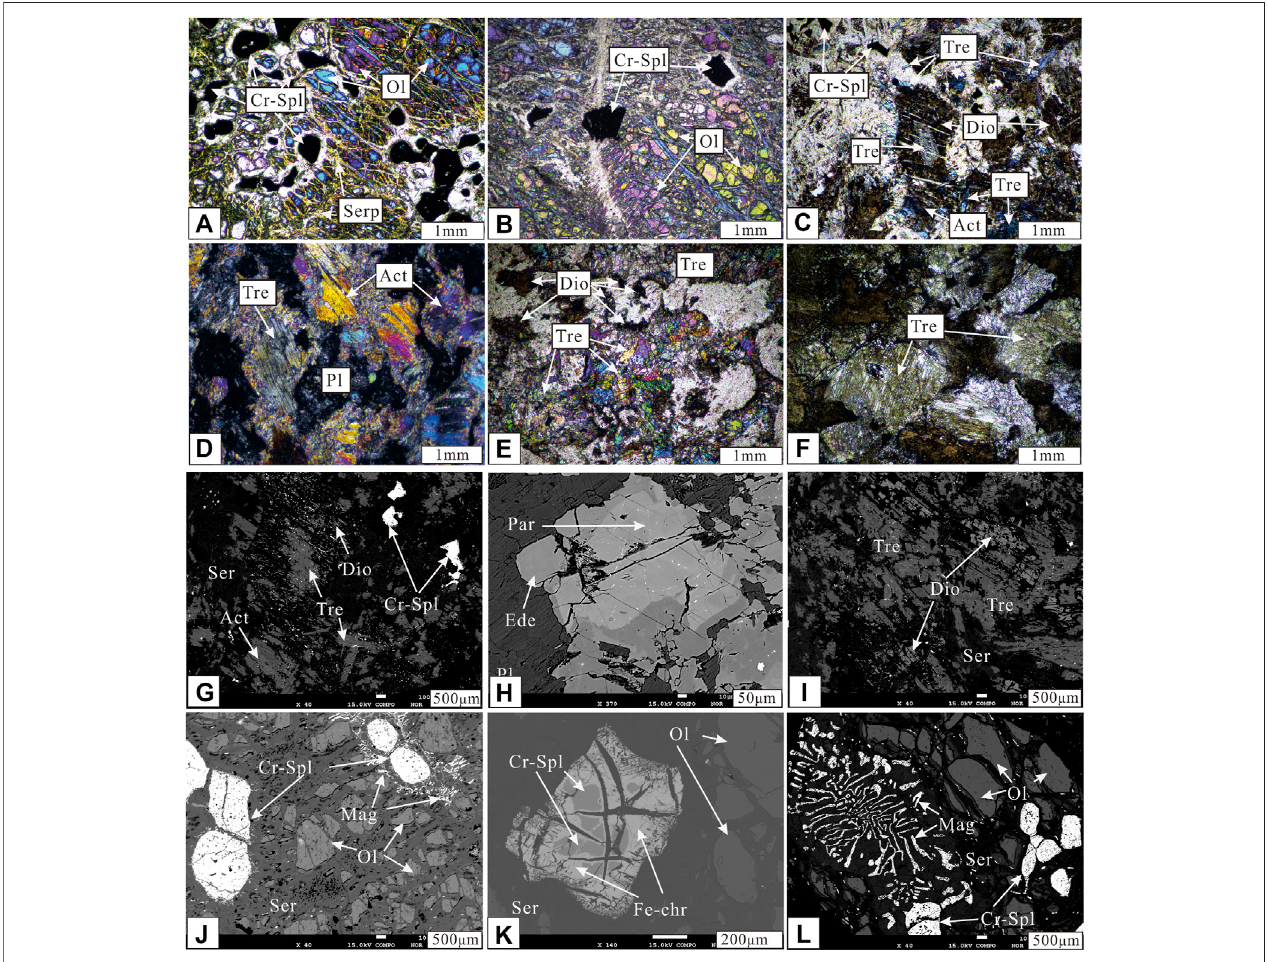
FIGURE 5 | Photomicrographs and backscattered electron (BSE) images of clinopyroxene peridotite and dunite. (A) Medium-density disseminated chromites in dunites; (B) Scattered chromites in dunites; (C) Diopsides in clinopyroxene peridotite are replaced by neogenic tremolite and actinolite; (D, F) Diopsides in altered gabbros are altered to actinolite and tremolite, and plagioclases are commonly altered to zoisite; (E) Residual diopsides in serpentine and neogenic tremolite; (G, I) Neogenic actinolite and tremolite in clinopyroxene peridotite; (H) unaltered pargasite and endenite in altered gabbro; (K) Chrome spinel (dark gray) with melting corrosion structure, altered to ferritchromite (Fe-chr) (lighter gray) along cracks and margins of Cr-spinel in scattered chromites-bearing dunite; (J, L) Medium density disseminated subhedral chromites and skeleton-texture magnetite in dunite. ( A – E : cross-polarized light; F : plane-polarized light; G – L : backscattered electron (BSE) images; Ser — serpentine; Act — actinolite; Dio — diopside; Tre — tremolite; Par — pargasite; Ede — endenite; Ol — olivine; Cr-Spl — chrome spinel; Mag — magnetite; Pl — plagioclase; Fe-chr — ferritchromite).